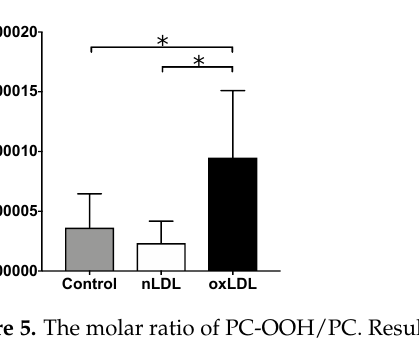
Figure 5. The molar ratio of PC-OOH/PC. Results are shown as mean ± standard deviation. n = 5 – 6. One-way ANOVA with Tukey’s multiple comparisons test, * p < 0.05.